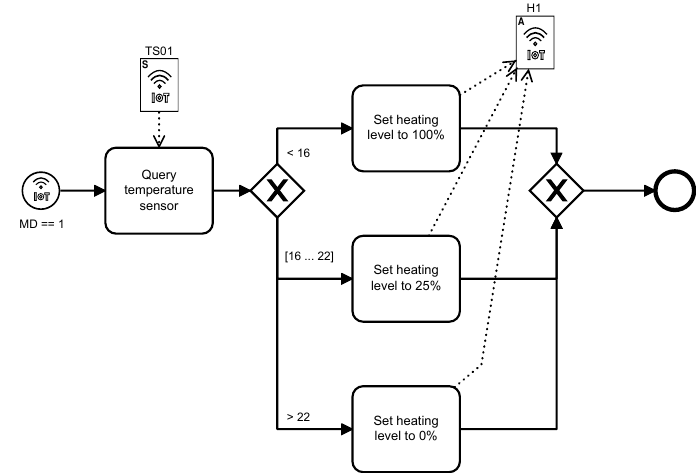
Figure 19. Process to control the temperature in a smart